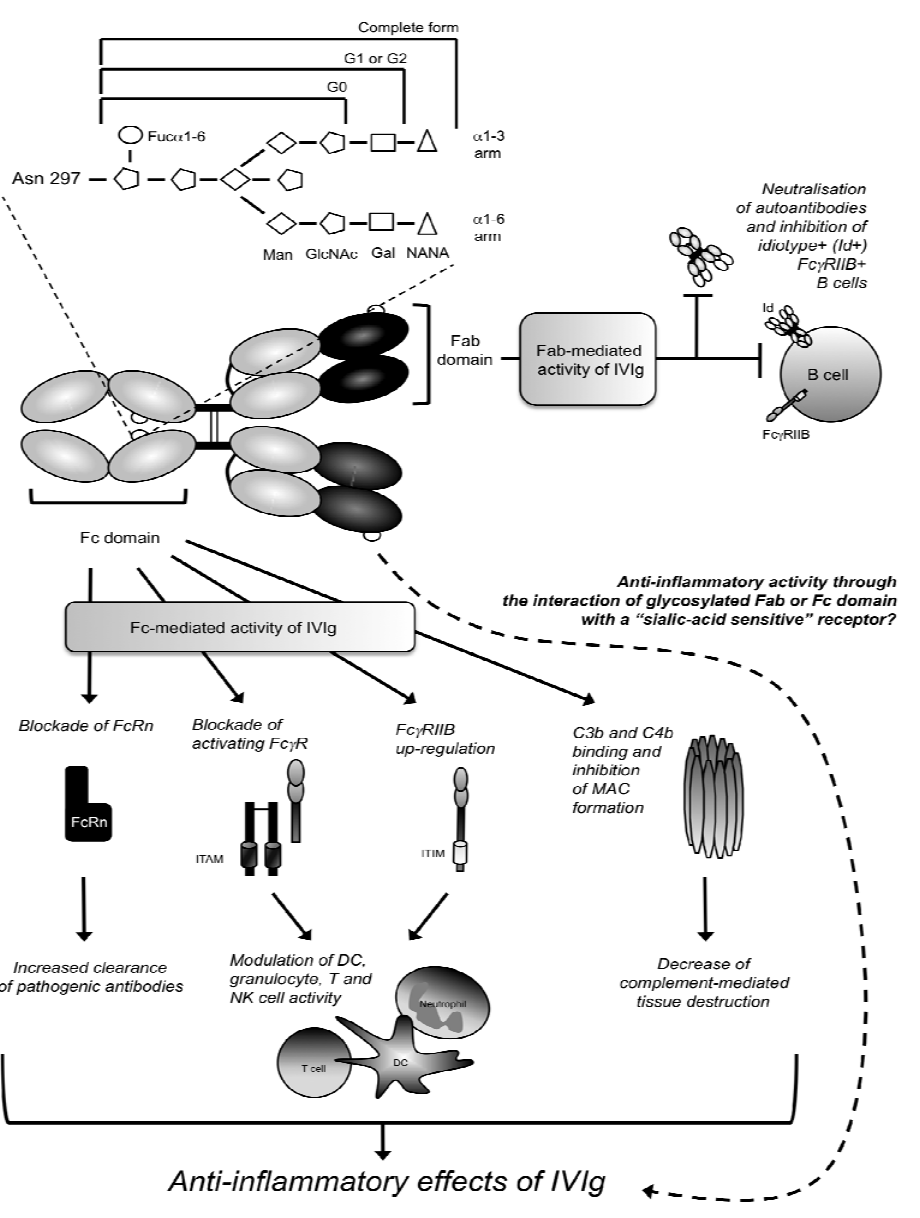
Figure 1. Mechanisms of action of IVIg. Enlarged representation of the Asn297-linked oligosaccharide complex is shown [Fuc α 1-6: fucose( α 1-6); Man: mannose; GlcNAc: N- acetyl-glucosamine; Gal: galactose; NANA: sialic acid]. IVIg mechanisms of action can be divided in two categories: (A) Fab-mediated activity against immunoregulatory or pathogen-related molecules, or presence of anti-idiotype (Id) antibodies that can neutralize autoantibodies and inhibit Id + Fc γ RIIb + pathogenic B cells. (B) Fc-mediated activity of IVIg through different mechanisms: (i) competitive blockade of FcRn, (ii) competitive blockade of activating Fc γ R and up-regulation of Fc γ RIIB and (iii) C3b and C4b binding leading to an indirect inhibition of membrane attack complex (MAC) formation. These molecular mechanisms trigger (i) an increased clearance of pathogenic endogenous antibodies, (ii) the modulation of DC, granulocyte, T and NK cell activity and (iii) a decrease of complement-dependent tissue destruction, respectively. Altogether, Fc- mediated mechanisms ultimately lead to anti-inflammatory